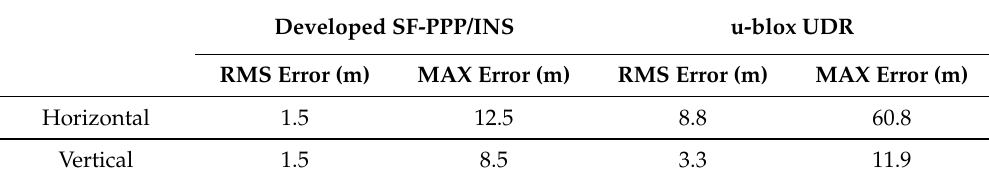
Table 2. The RMS and maximum position errors for the whole of the second trajectory. The developed SF-PPP/INS system errors are less than the UDR errors. The maximum errors occurred when the vehicle entered the underground